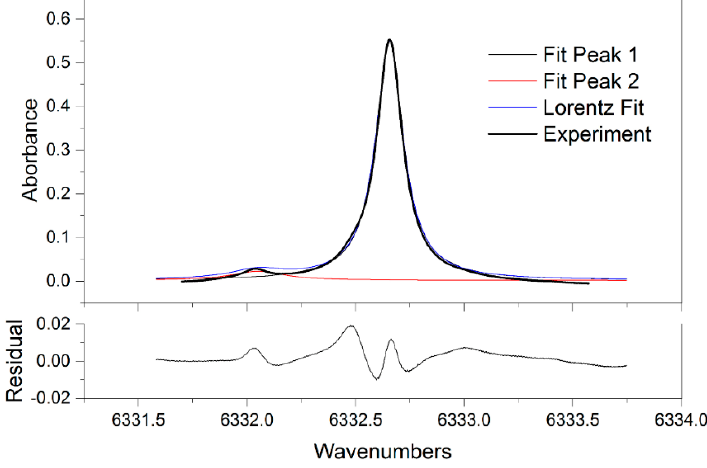
Figure 6. Measured CO 2 spectrum near 6332.7 cm − 1 with Lorentz fitting (P = 1 atm, T = 338 K, 18% CO 2 ). Table 1. The relative errors of direct absorption results from 298 to 338 K. True Concentration